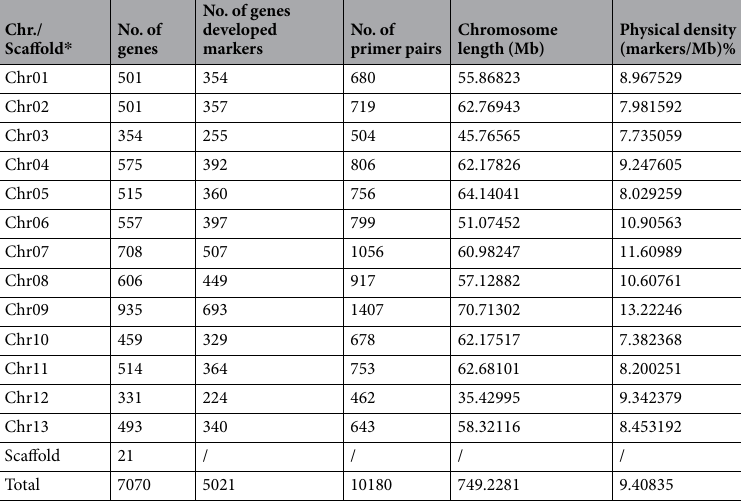
Table 1. Chromosome distribution of developed ILP markers in G . raimondii genome. * The nomenclature of Chr./Scaffold in G . raimondii is from Paterson et al . 18